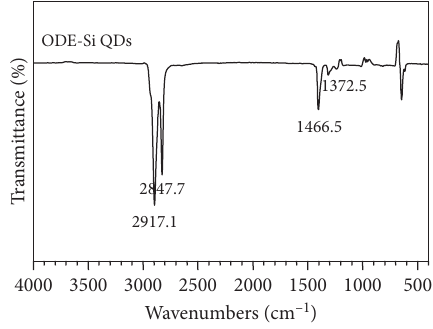
Figure 3: FT-IR spectra of ODE-Si